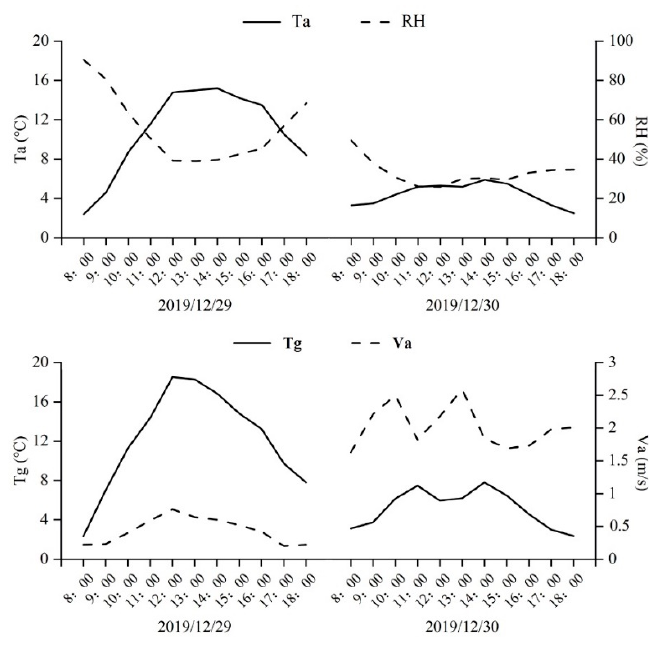
Figure 7. Hourly mean Ta, RH, Tg, and Va on each